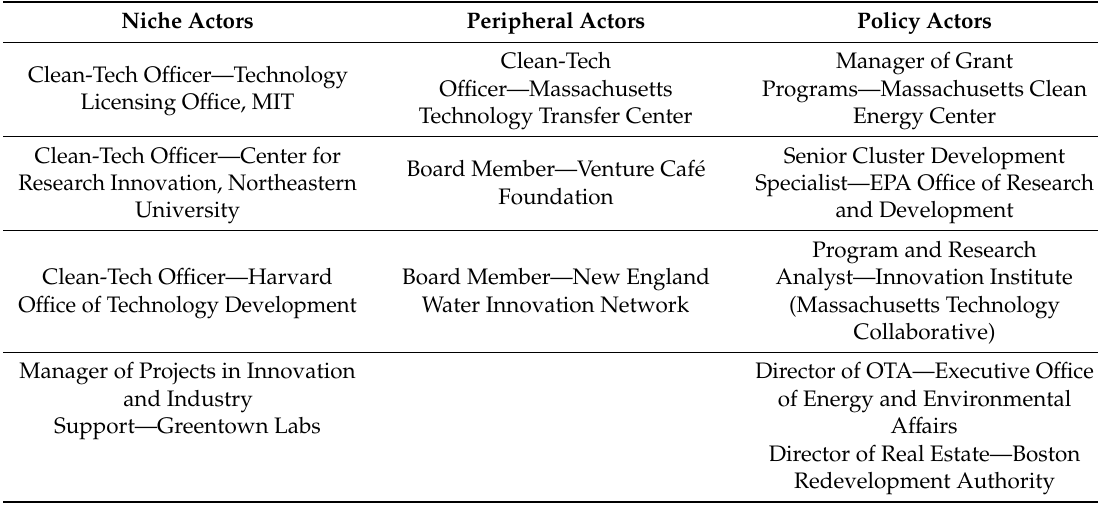
Table 1. List of key actors’